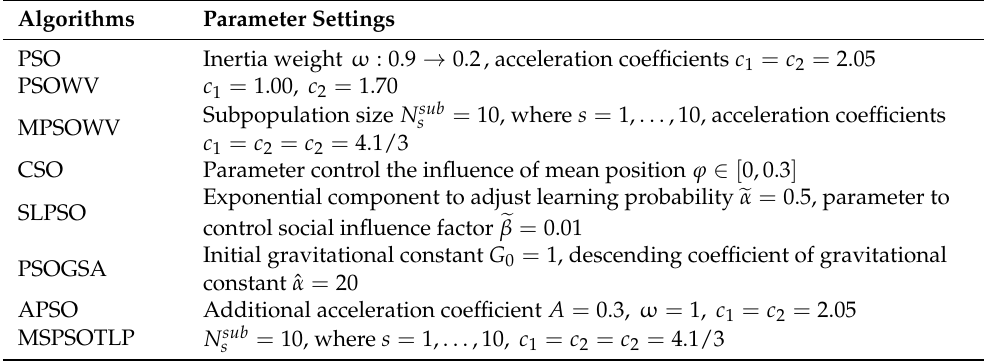
Table 4. Parameter settings of all compared algorithms.